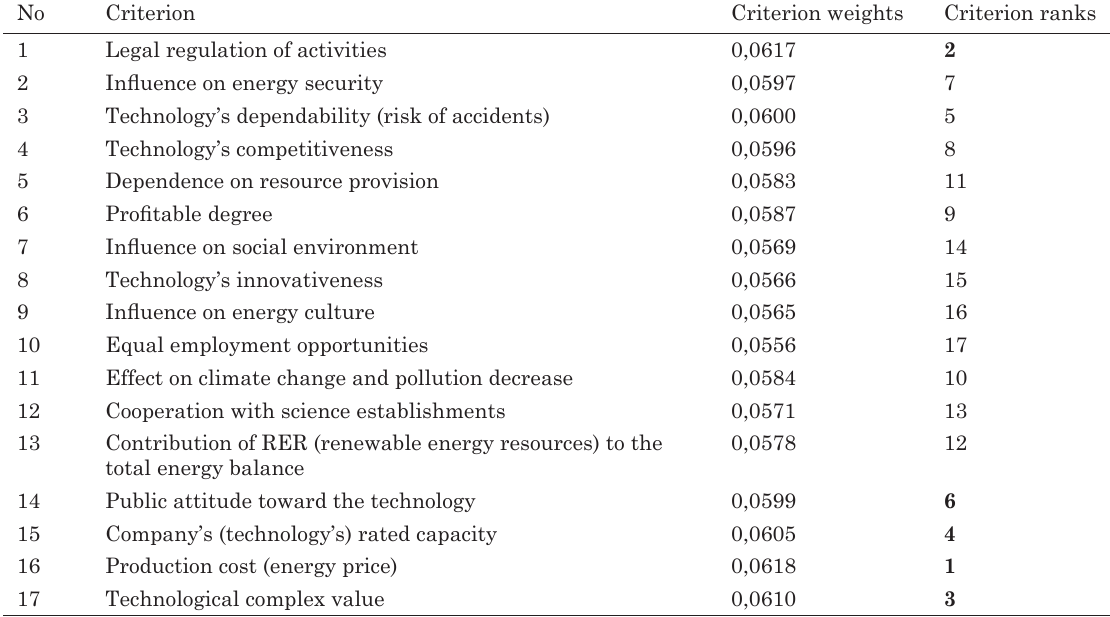
Table 2. criteria rankings no criterion criterion weights criterion